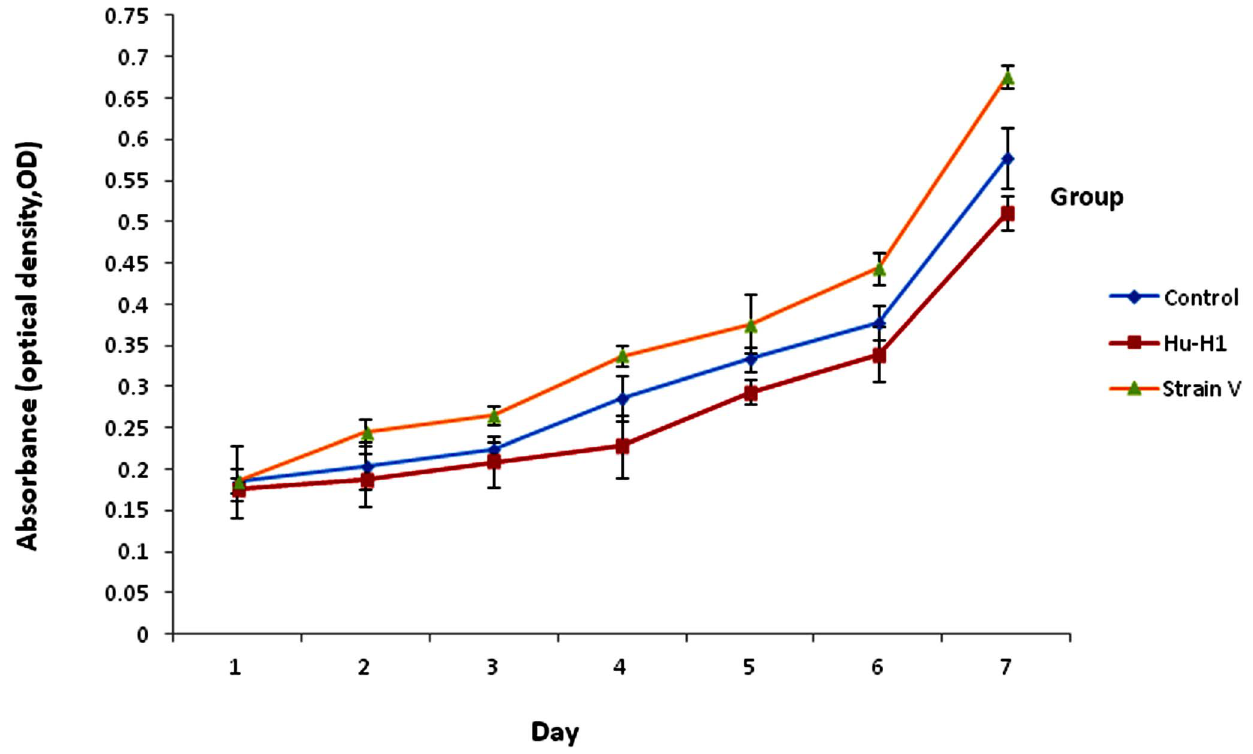
Figure 2. Cellular proliferation rates of Hu-H1, Strain V, and control cells.